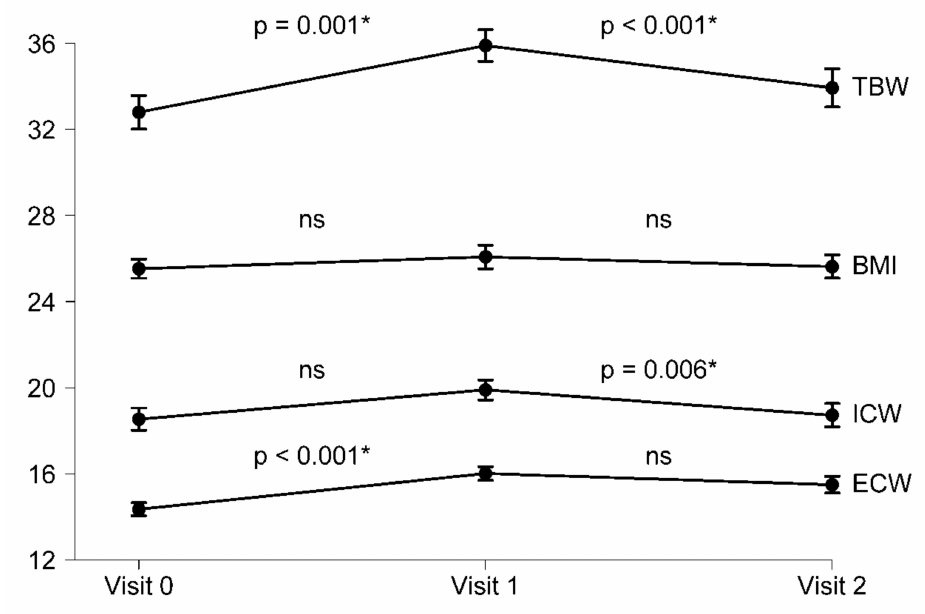
Figure 1. Progression of body composition in 124 hemodialysis patients over three years. TBW: total body water; BMI body mass index; ICW intracellular water; ECW extracellular water; ns no significance, * significance.